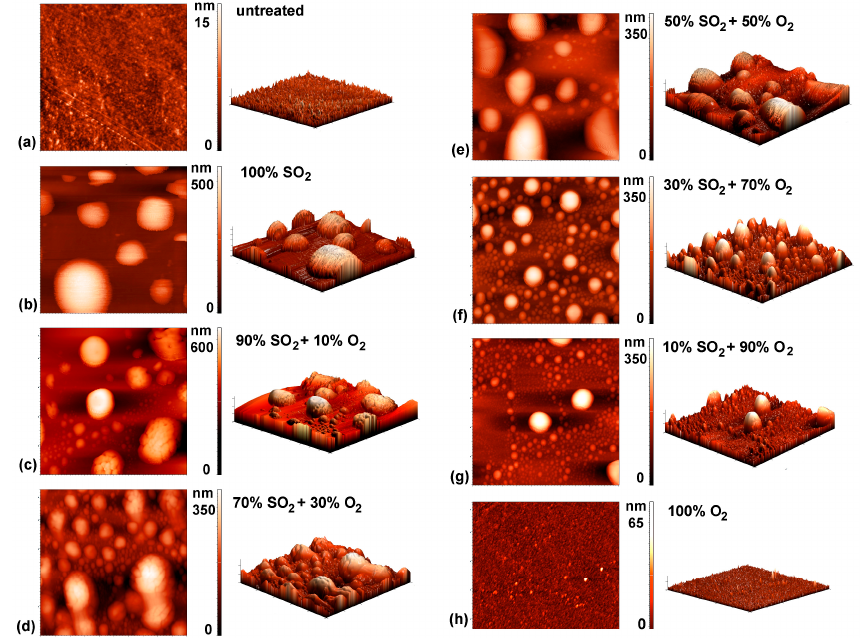
Figure 7. AFM images (5 × 5 µm 2 ) of the samples treated in various SO 2 + O 2 mixtures: ( a )